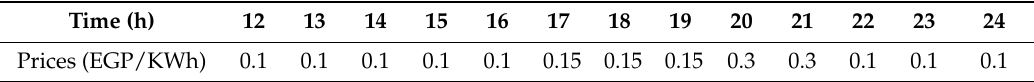
Table 3. Suggested time of use (ToU) electricity